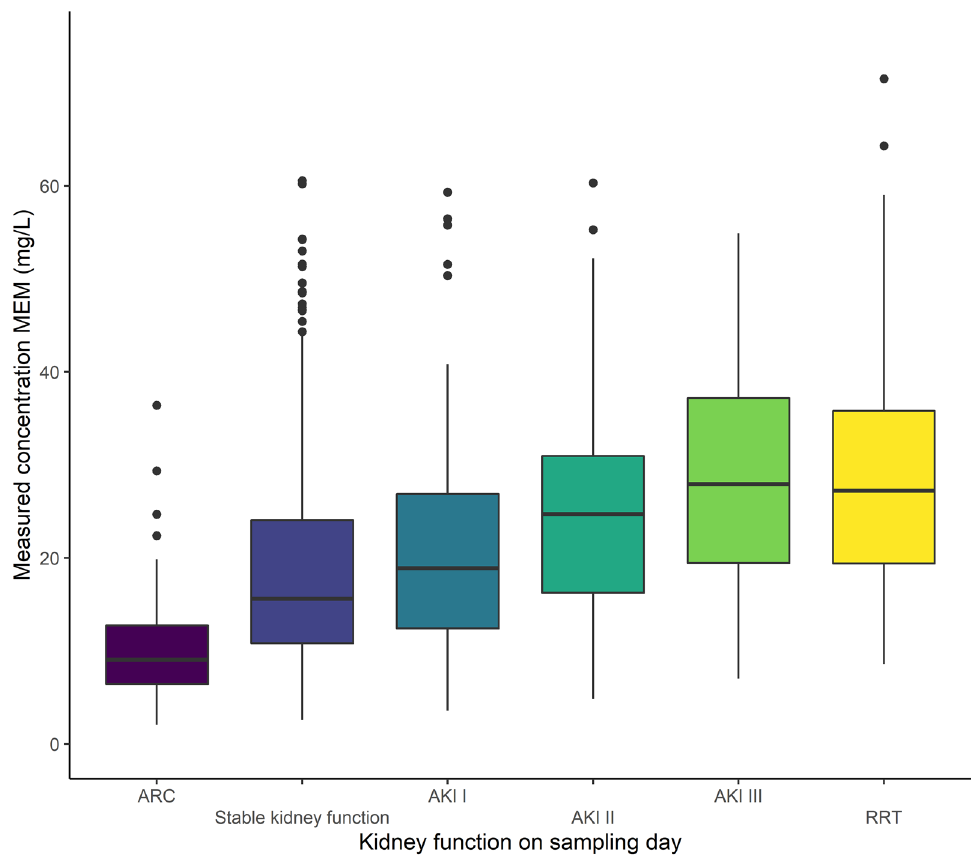
Fig. 7 Boxplot of free MEM concentrations according to renal function on the sampling